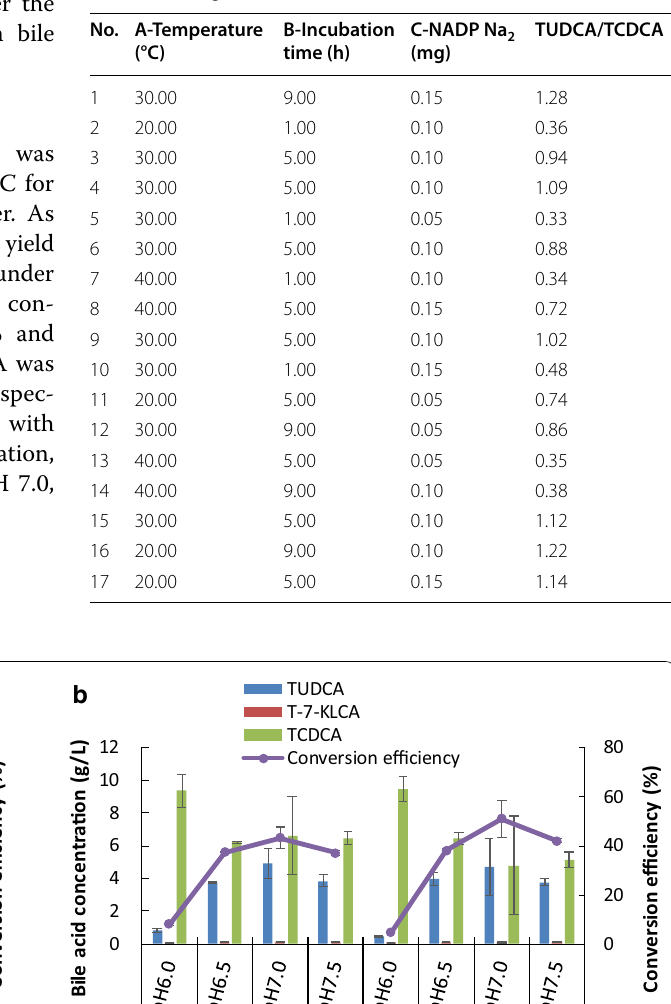
Table 1 Experimental designs and the results of the